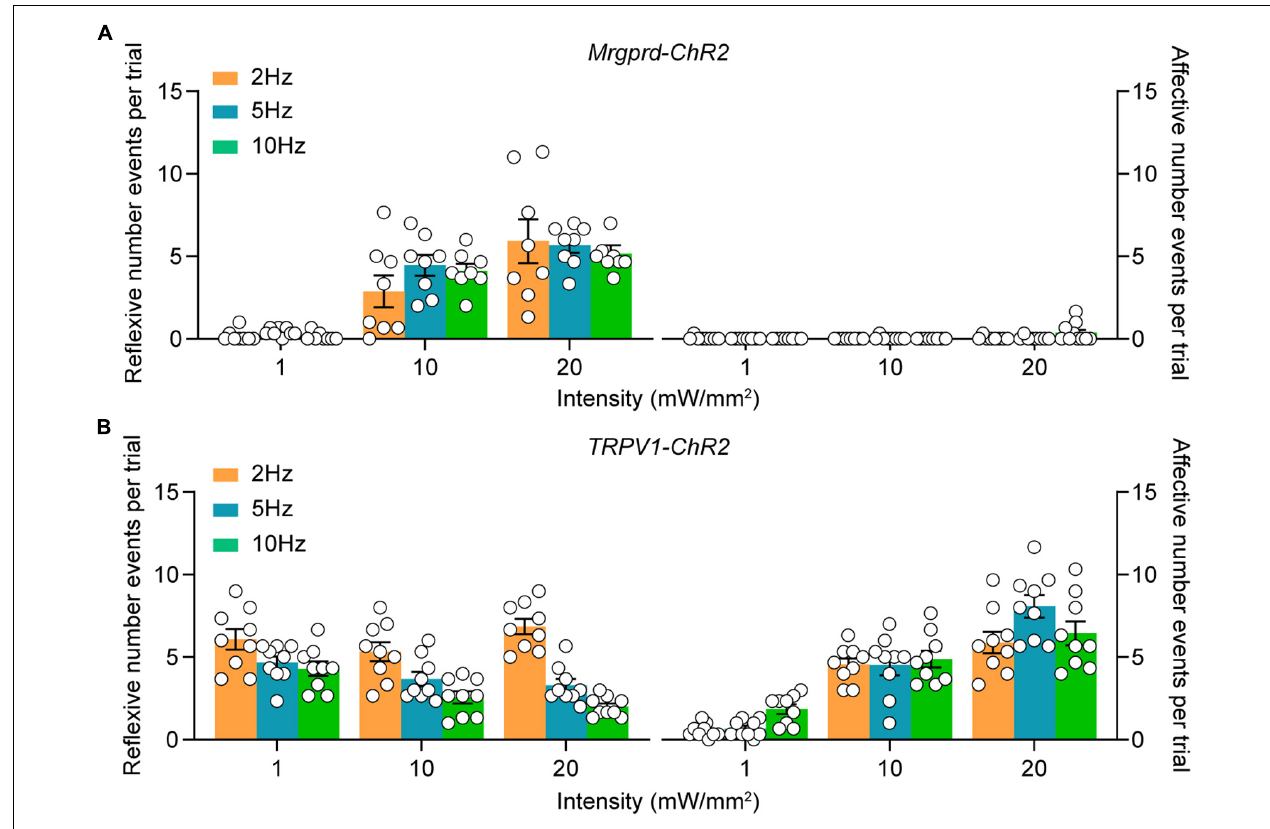
FIGURE 2 | Characterization of cutaneous blue light-evoked nocifensive behaviors in naïve Mrgprd-ChR2 and TRPV1-ChR2 mice. (A,B) Reflexive and affective behaviors evoked by hindpaw plantar blue light stimulation at different intensities and frequencies in naïve Mrgprd-ChR2 mice ( n = 8 animals) (A) and TRPV1-ChR2 mice ( n = 9 animals) (B) . Data are presented as mean ±